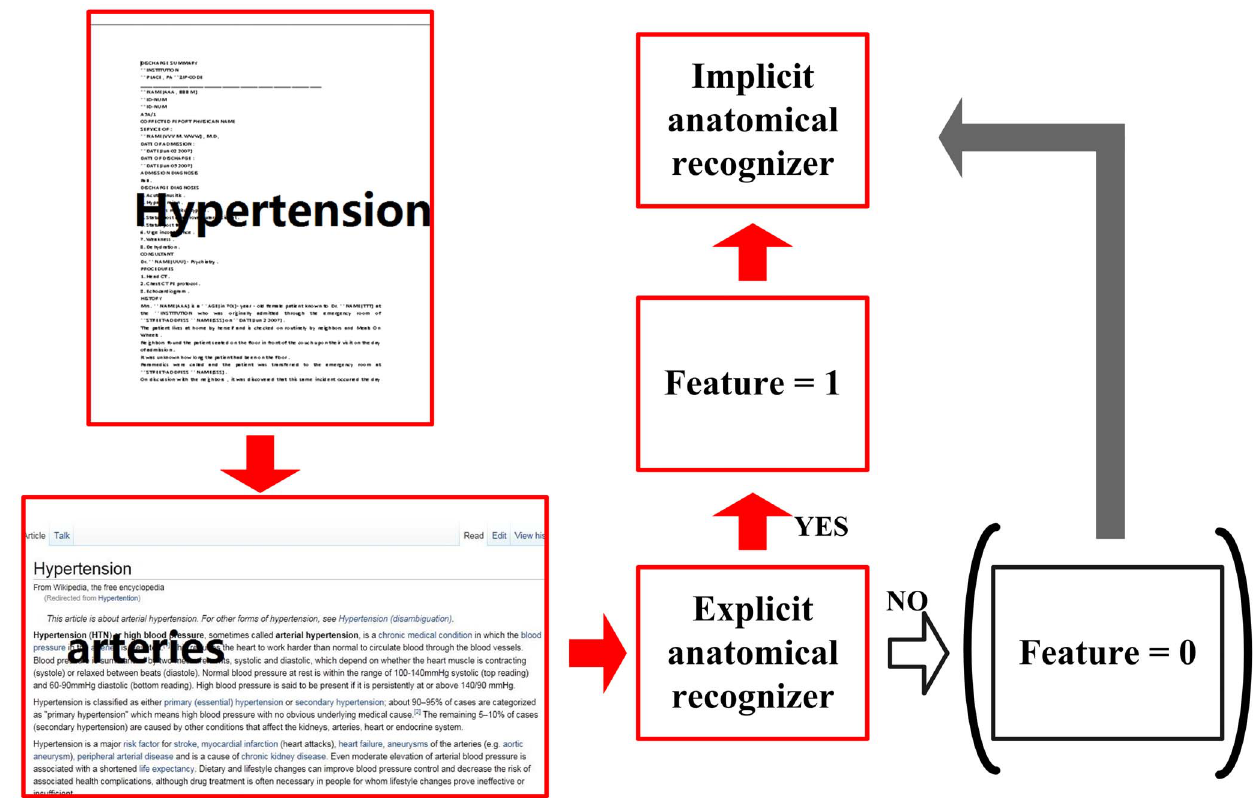
Figure 4. Building the hierarchical feature for implicit anatomical recognizer.